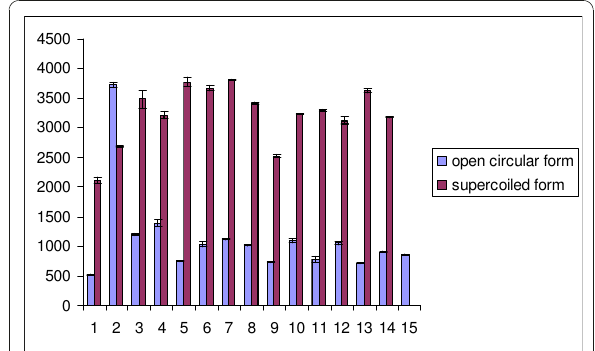
Figure 2 Densitometric analysis of open circular and supercoiled DNA damage induced by · OH generated from the Fenton reaction in the presence of plant extracts . Lane 1: untreated control DNA (250 ng); lane 2: FeSO 4 (0.5 mM) + H 2 O 2 (25 mM) + DNA (250 ng); lane 3: only H 2 O 2 (25 mM) + DNA (250 ng); lane 4: only FeSO 4 (0.5 mM) + DNA (250 ng); lanes 5 – 15: FeSO 4 (0.5 mM) +